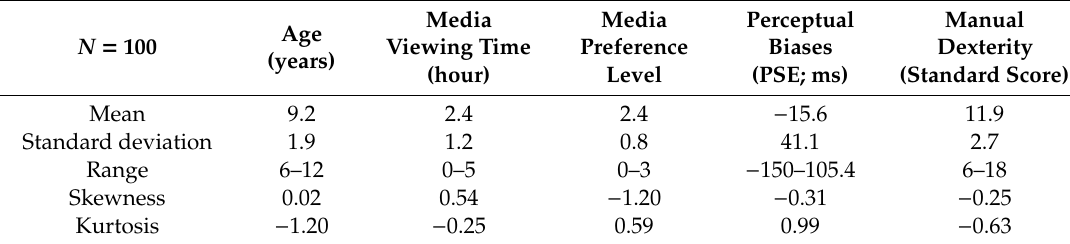
Table 2. Summary of collected data.